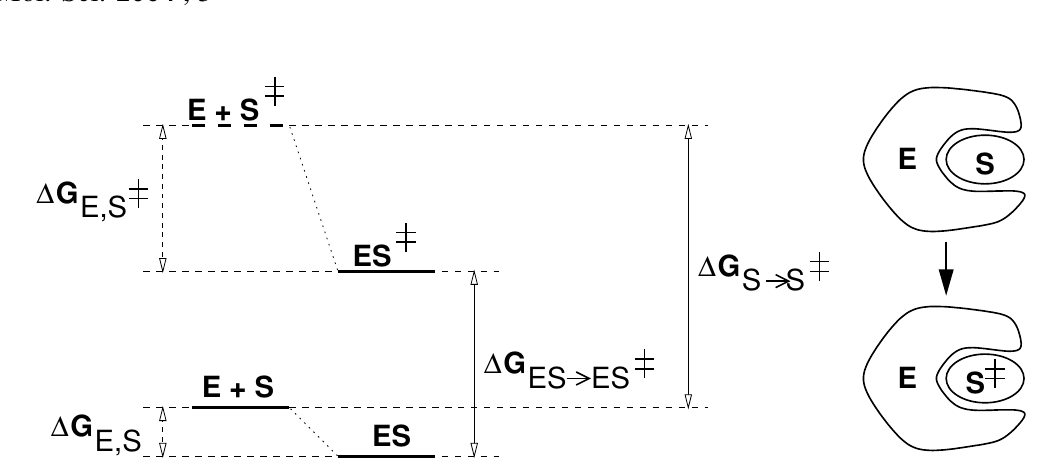
Figure 1: Illustration of the transition state stabilization by the enzyme environment (Eq. 1). Note that S ‡ (transition state) and S (substrate) are equivalent to TS and SC, respectively, used elsewhere (e.g. in [1]).